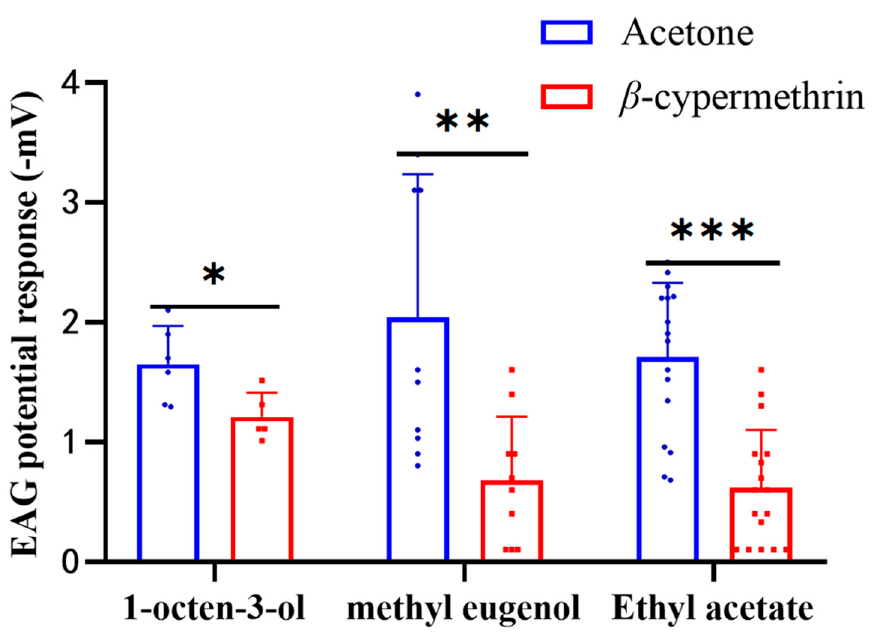
Figure 2. EAG recording of 7-day-old flies treated by β -cypermethrin (LD 30 = 10 ng/fly). The EAG data was obtained by stimulating flies with three odorants including 1-octen-3-ol, methyl eugenol and ethyl acetate at 1% ( v / v ) concentration. Ethyl acetate and 1-octen-3-ol were diluted with MO and methyl eugenol was diluted with DMSO. Females, males and both sexes were employed in the assays of 1-octen-3-ol, methyl eugenol and ethyl acetate, respectively. Data were presented as mean ± SE, and asterisks represent a significant difference with analysis of Student’s t -test ( n = 8–12, * p < 0.05; ** p < 0.01; *** p < 0.001).